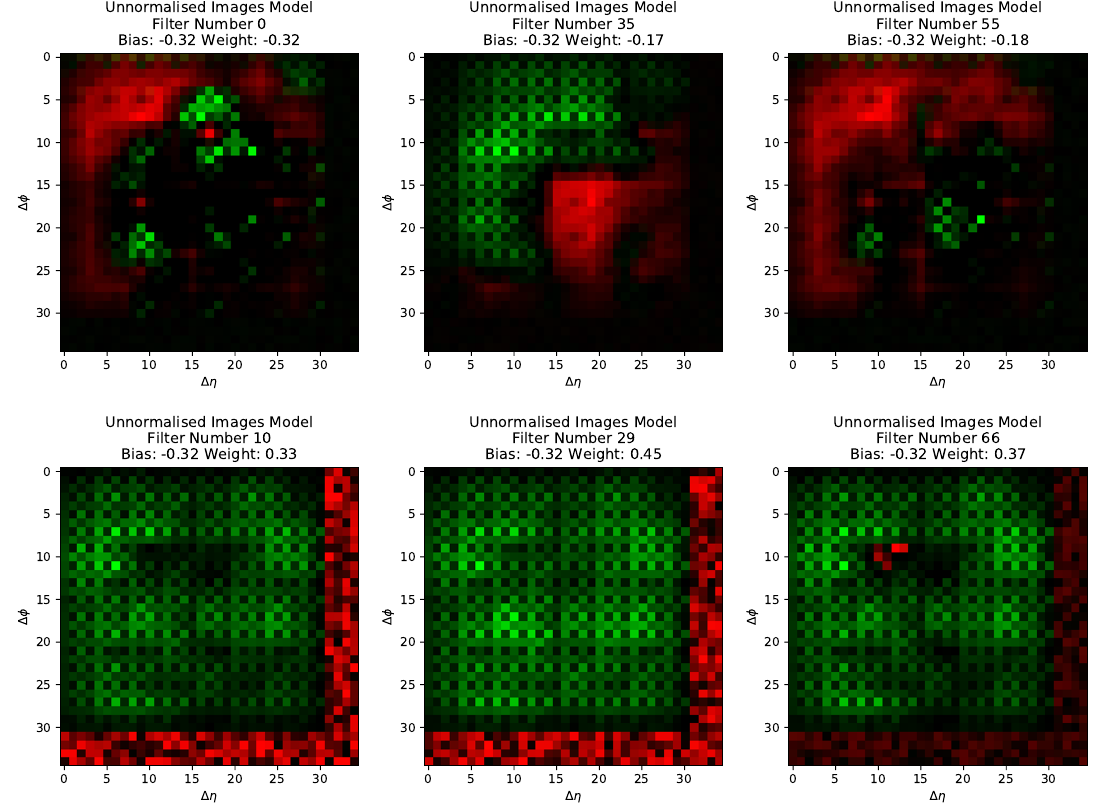
Figure 19 . The most discriminative patterns of the unnormalised images. Red represents the transverse momentum channel, green the multiplicity channel. Brighter pixels represent the pattern that maximised the activation of the respective filter. Since the top (bottom) filters have a negative (positive) weight, they are being triggered by vacuum (medium) sample